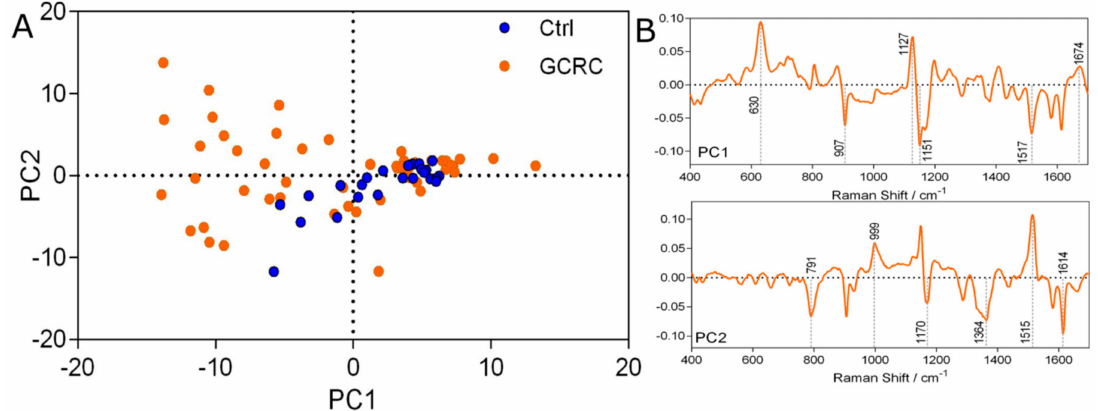
Figure 3. Principal component analysis (PCA) of the SERS spectra of serum. ( A ) The first two principal components (PCs) of PCA shows the clustering of the SERS spectra of serum from 25 control subjects (Ctrl) and 53 patients with gastric and colorectal cancer (GCRC). ( B ) The corresponding loading plots of PC 1 and PC